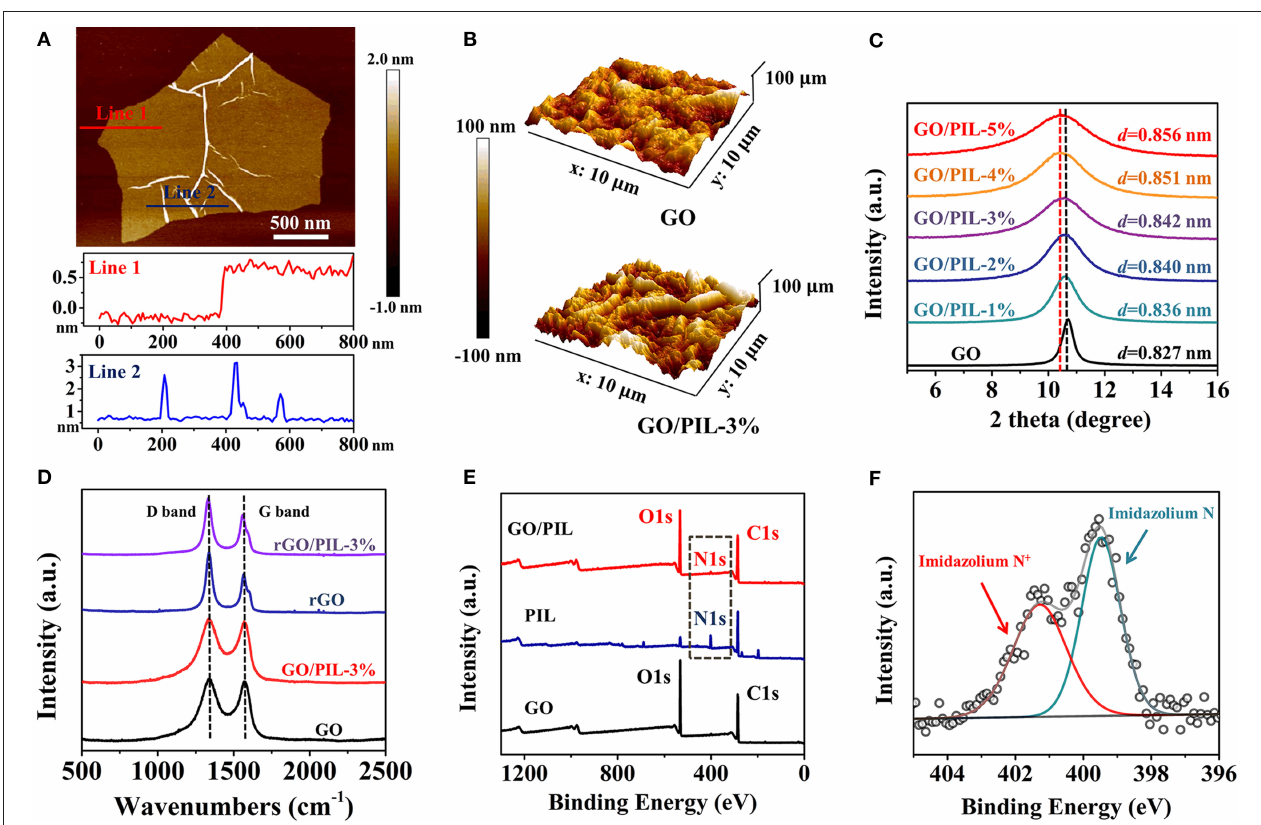
FIGURE 2 | (A) A representative AFM image of the prepared GO sheet and its corresponding height profile. (B) 3D AFM images of the pristine GO film (top) and GO/PIL-3% (bottom). (C) XRD patterns of the pristine GO film and GO/PIL- x %, x = 1 to 5. (D) Raman spectra of GO, GO/PIL-3%, rGO and GO/PIL-3% films. (E) XPS spectra of the pristine GO film, PIL, and GO/PIL-3%. (F) The high resolution spectrum of N1s of GO/PIL-3%. AFM, Atomic force microscopy; PIL, poly(1-benzyl-3-vinylimidazolium chloride); XRD, X-ray diffraction; XPS, X-ray photoelectron spectroscopy.